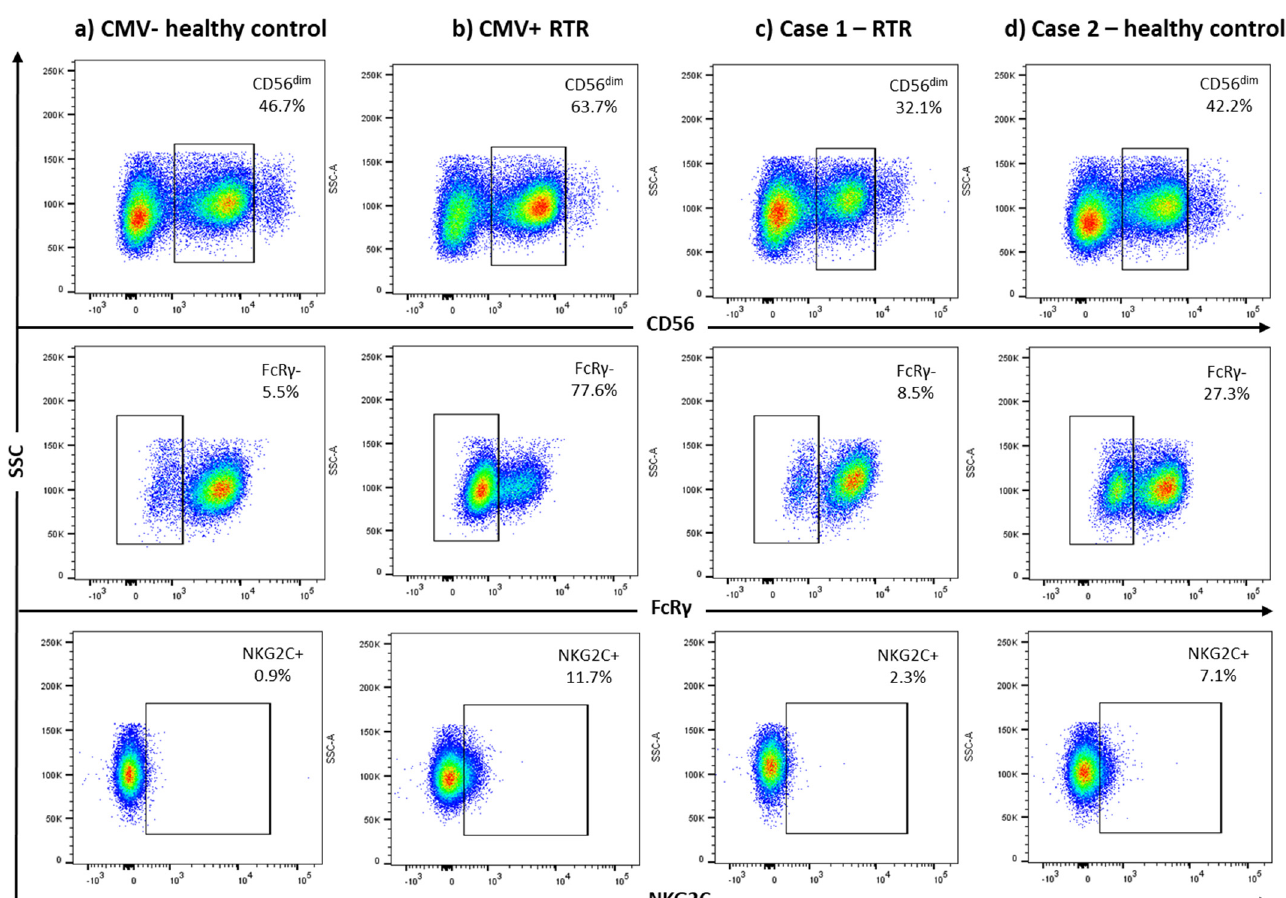
Figure 1. FcR γ and NKG2C expression on NK cells. Representative flow cytometry plots for a CMV seronegative healthy control ( a ) and a CMV seropositive renal transplant recipient (RTR) ( b ), Case 1 ( c ) and Case 2 ( d ). Gating strategy: singlets were first defined by forward scatter area (FSC-A) and forward scatter height; lymphocytes were then gated based on the side scatter area and FSC-A, and dead cells were excluded based on uptake of Fixable Viability Stain. Lack of FcR γ expression (middle panel) and expression of NKG2C (bottom panel) were assessed in NK cells identified as CD3 − CD56 dim (top panel). Antibodies used were BUV395-anti-CD3 (clone UCHT1), PE.Cy7-anti-CD56 (clone MEM-188; Biolegend, San Diego, CA, USA) and APC-anti-NKG2C (clone 134591; R&D systems, Minneapolis, MN, USA), and FITC-anti-FcR γ (Merck Millipore, Darmstadt, Germany).